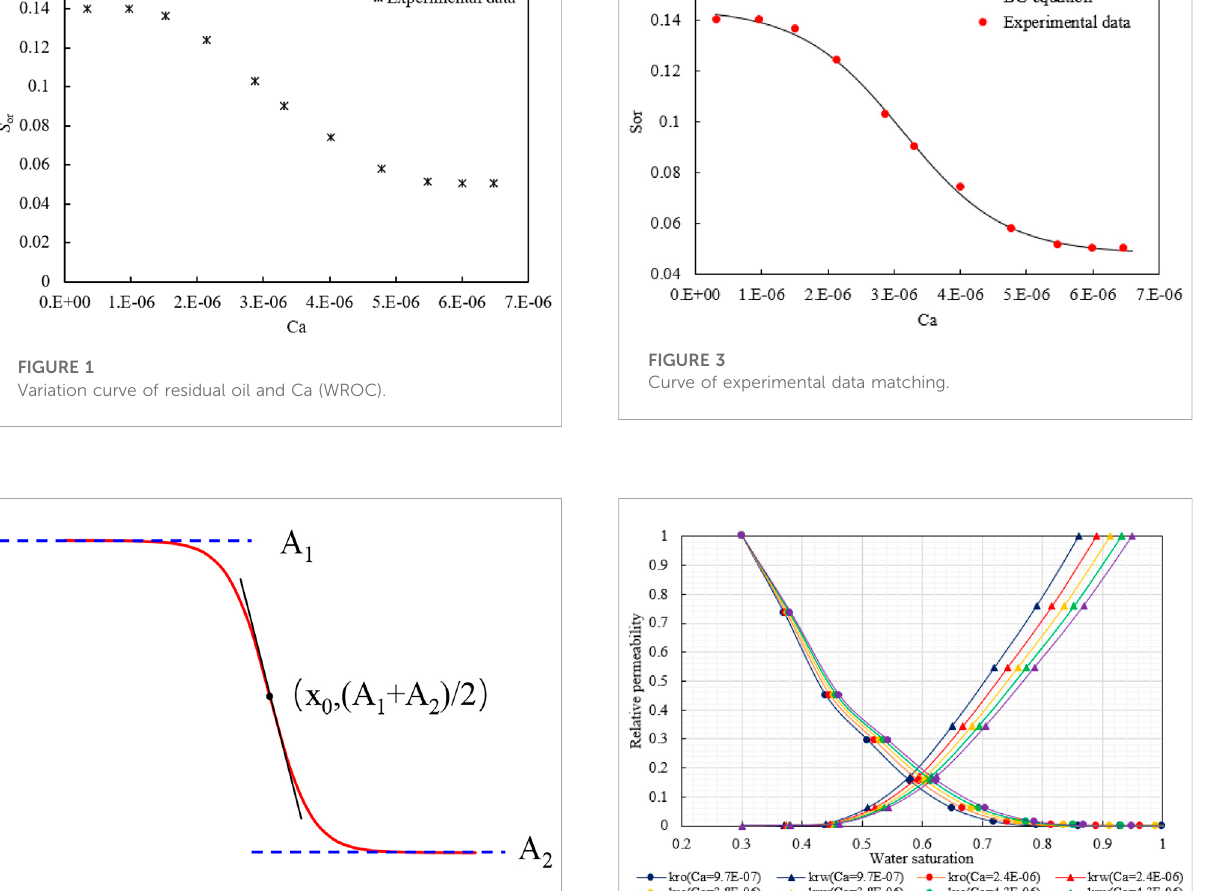
FIGURE 2 Schematic diagram of BG equation.